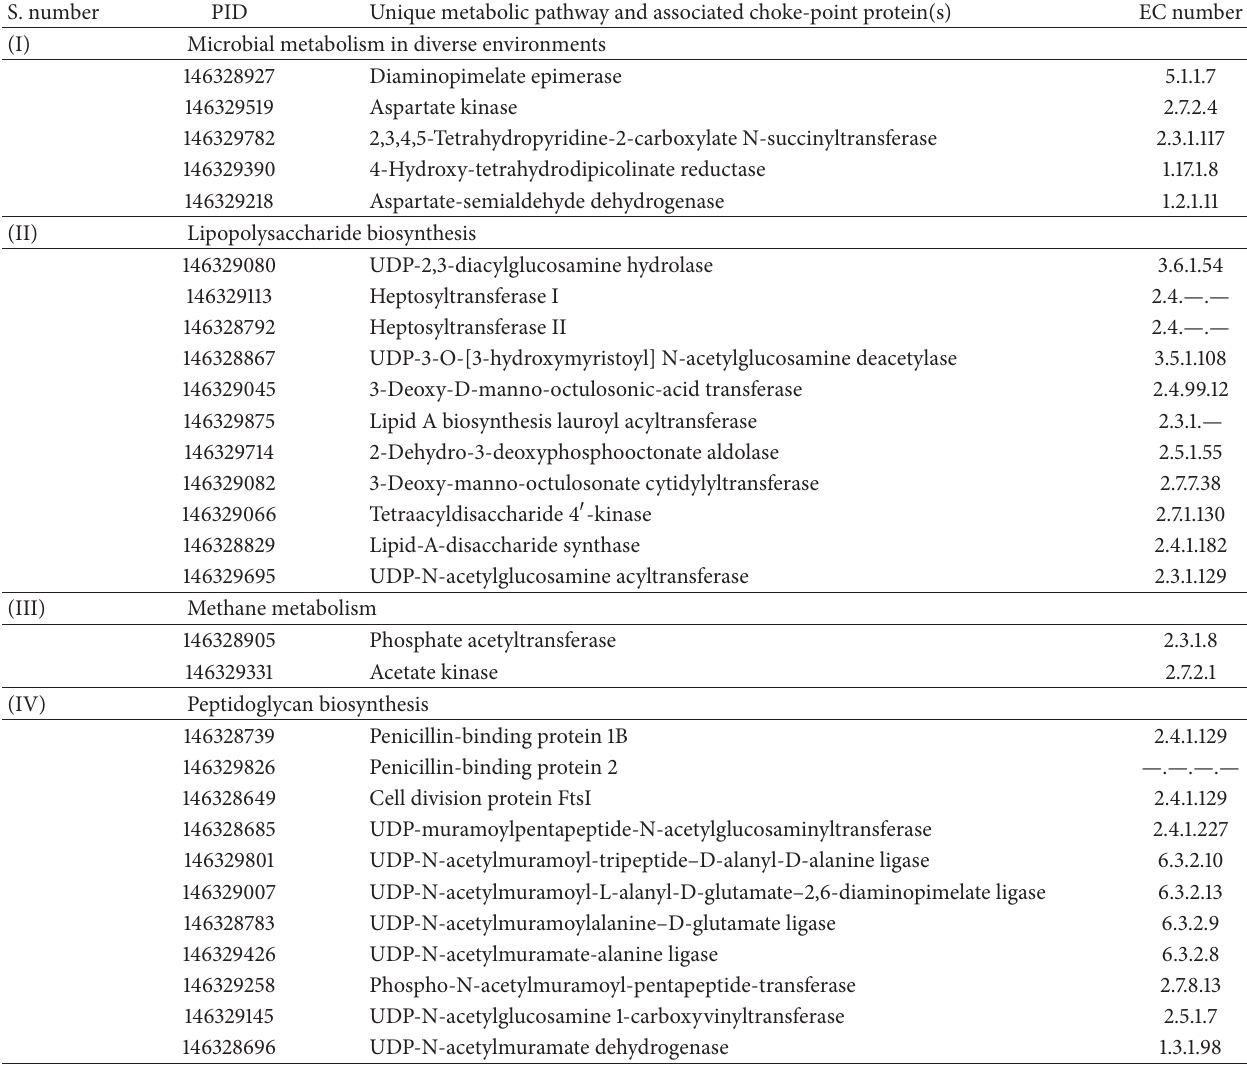
Table 2: List of 29 proteins that are part of unique bacterial pathways that are completely absent in host and are also choke-point proteins. S.